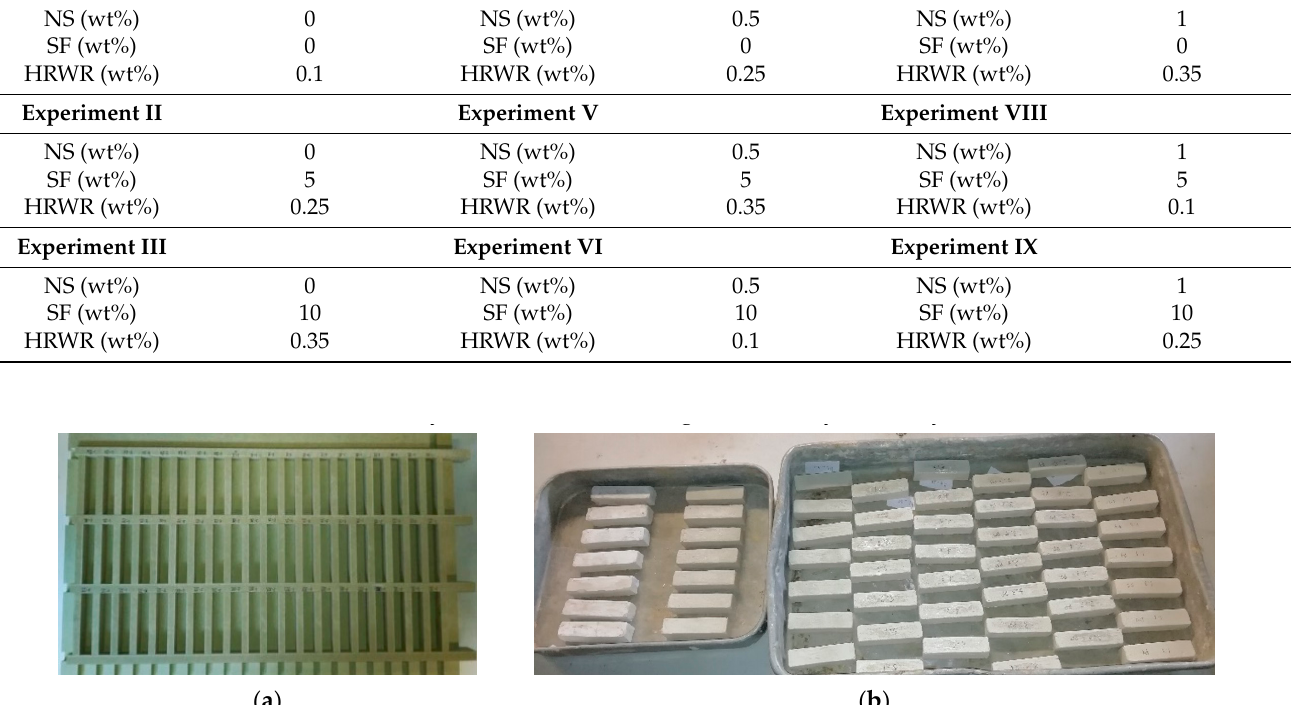
Figure 1. Grout preparation: ( a ) Sonicator for dispersion of NS; ( b ) Sonicator apparatus used.